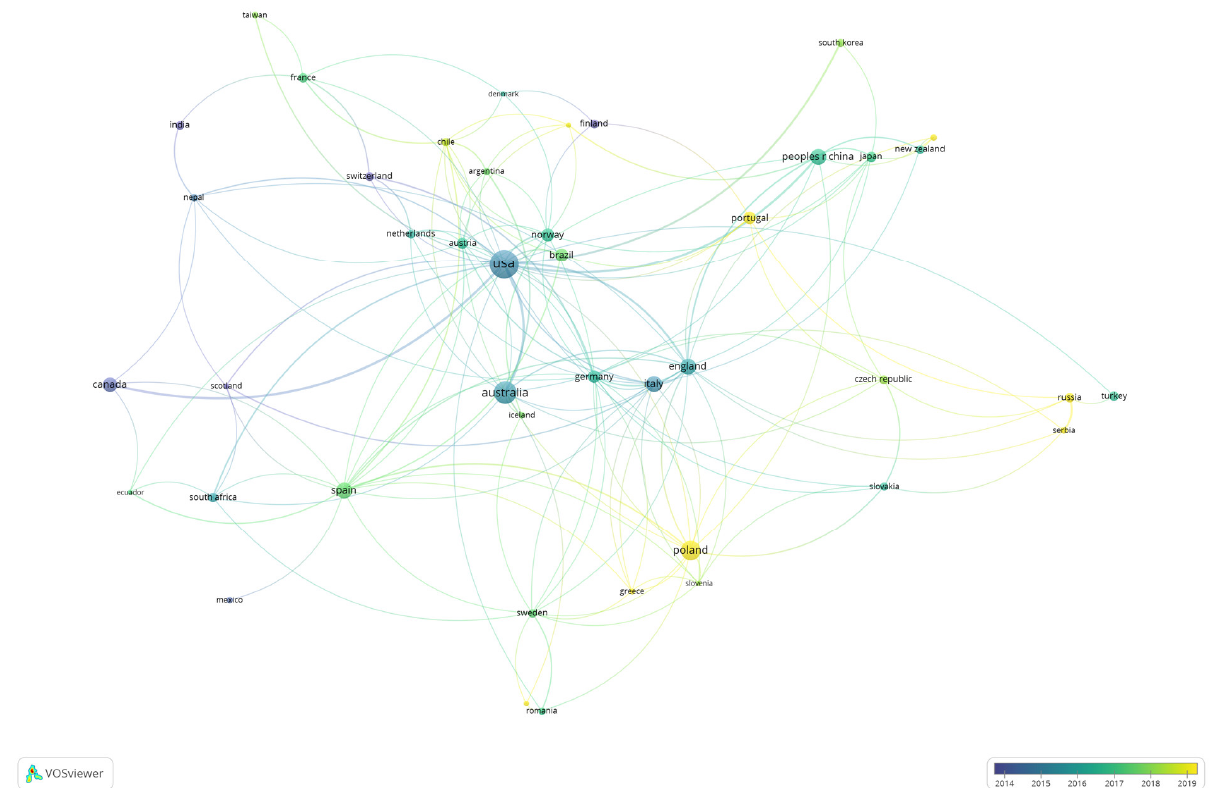
Figure 4. Bibliographic data map of co-authorship analysis (based on countries).